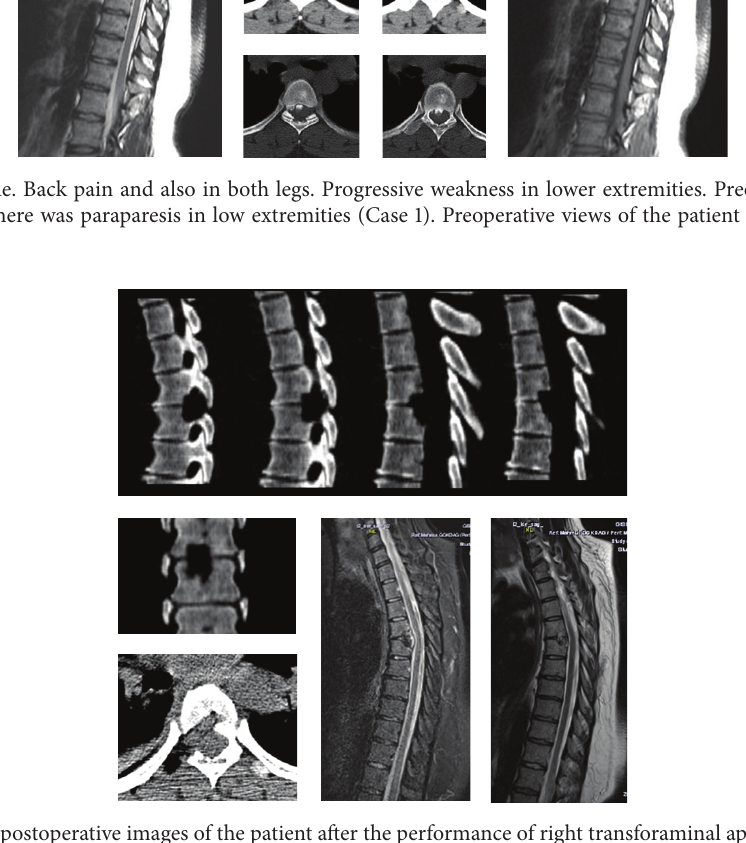
Figure 2: Early postoperative images of the patient after the performance of right transforaminal approach (Case 1).